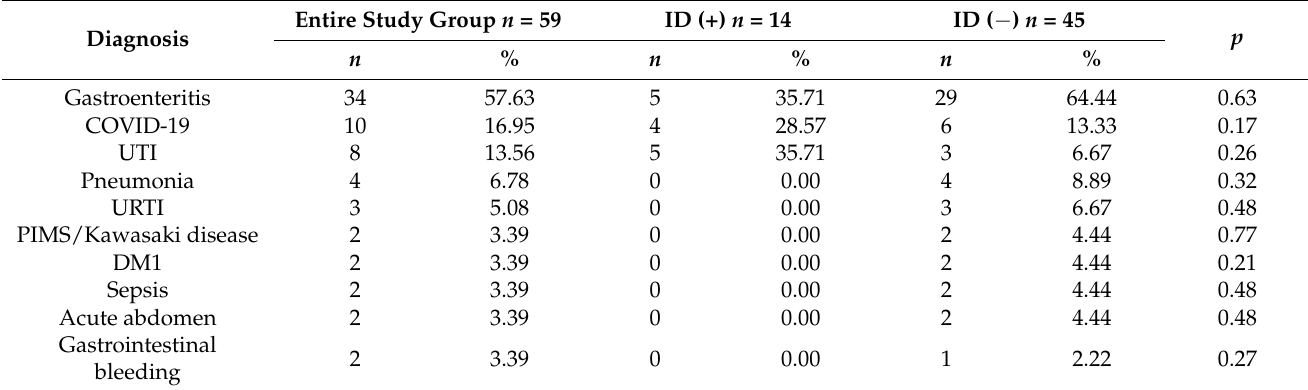
Table 4. Final diagnosis in children who had gastrointestinal symptoms.